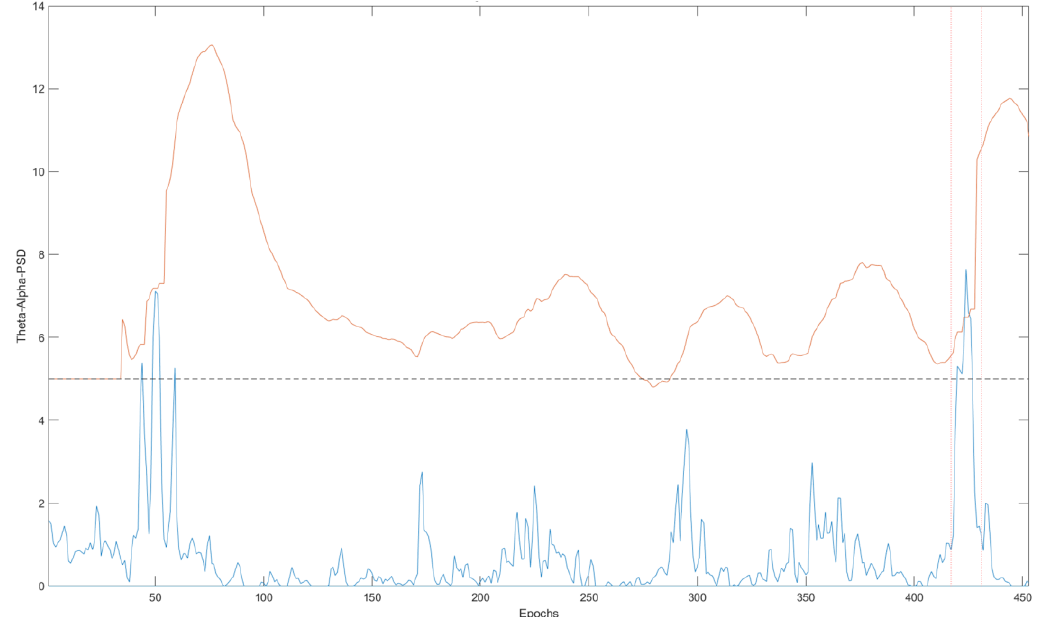
Figure 2. An example of PBI and the dynamic PBI threshold. The blue and orange lines illustrate the PBI for each epoch and the PBI dynamic threshold, respectively.